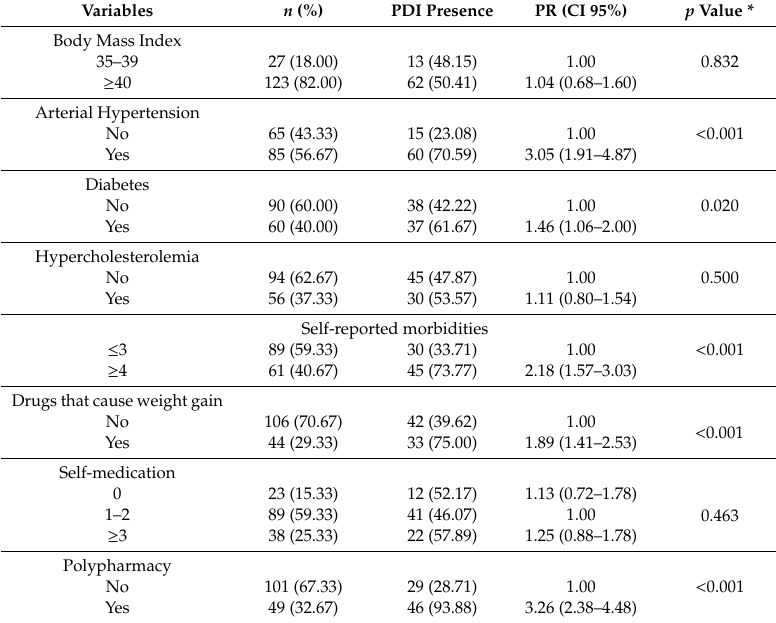
Table 3. Prevalence of Potential Drug Interactions and its association with health profile and drug use variables in adults with severe obesity ( n =